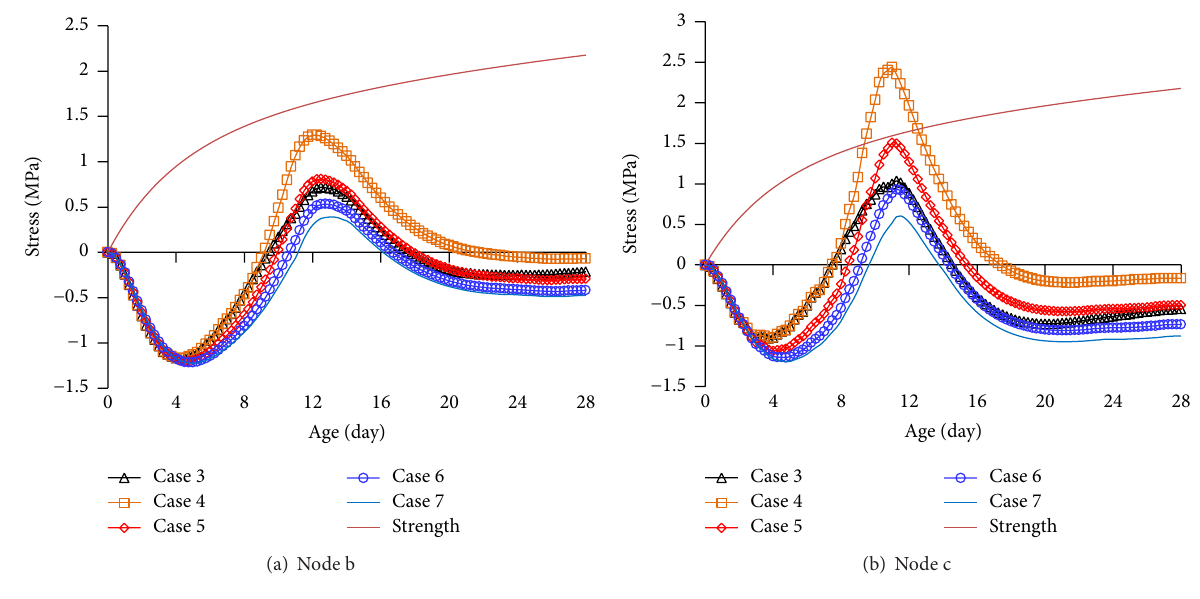
Figure 17: Thermal stress prediction results of typical nodes.